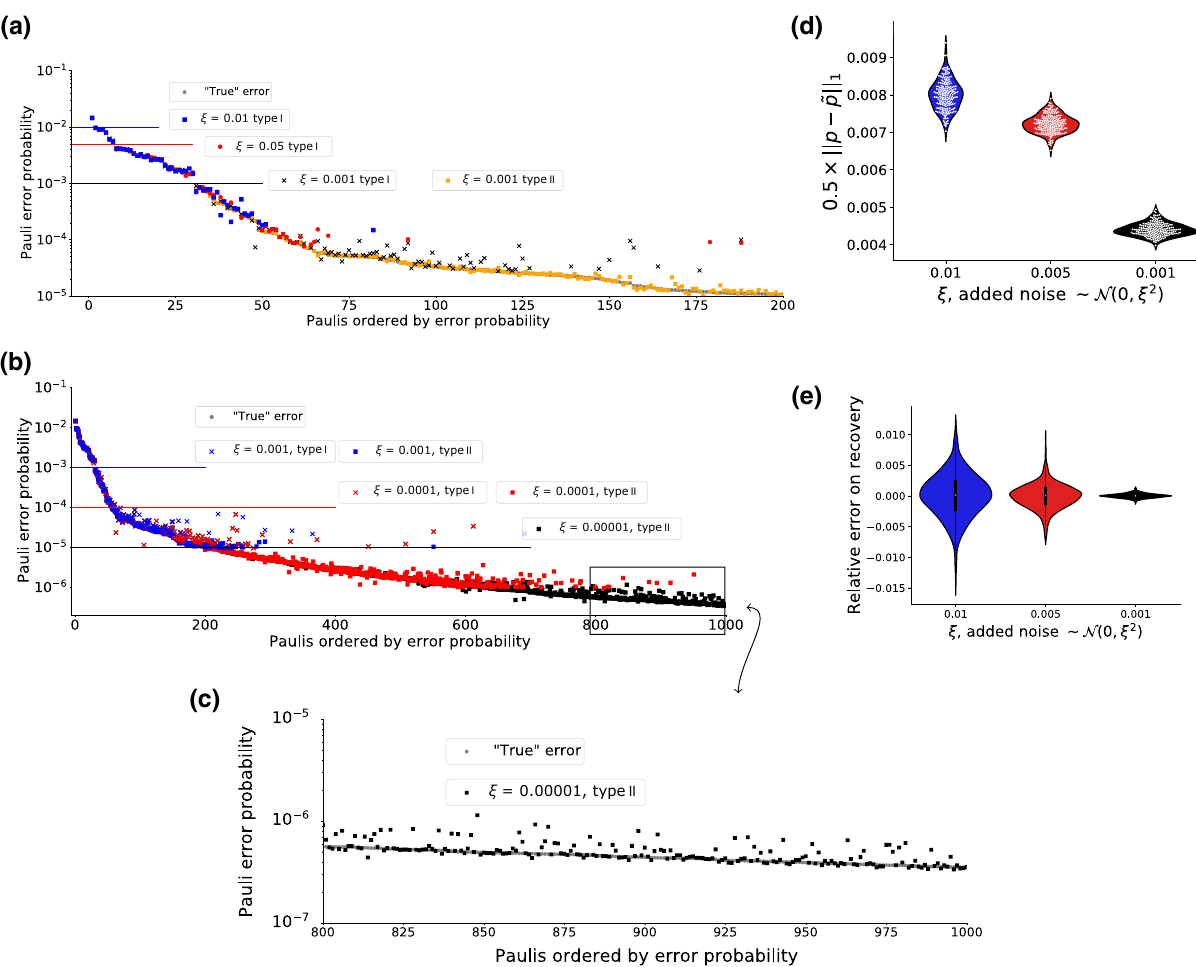
FIG. 1. (a) This figure shows the ability of the reconstruction algorithms to recover sparse Pauli error rates from experimental data. The “actual” error rates (barely visible beneath the data points representing the estimated error rates) are constructed using data from a 14-qubit experiment [38], as described in the main text (Sec. V). Dots indicate recovered Pauli error rates using our algorithm with artificially added zero mean normally distributed noise (variance ξ 2 ) on top of the true error rates to simulate finite sampling and other noise sources. The reconstruction used two experimental designs using a number of randomized benchmarking style experiments: type I (see Sec. V) used 58 and type II (see Sec. V A) used 365 such experiments, each with the same number of samples per experiment. The type-II experimental design runs more experiments and therefore takes more data overall, but allows recovery of an increasing number of Paulis while keeping constant the number of measurements per experiment. (b) The recovery of 1000 different error rates as low as 10 − 7 with high relative precision, when the experimental noise varies between ξ = 10 − 3 –10 − 5 . Notably, the error rates are recovered with a precision almost 2 orders of magnitude below the standard deviation ξ of the noise added to the signal. (c) a more detailed look at the recovery in the regime between 10 − 6 and 10 − 7 with noise levels of ξ = 10 − 5 . (d) Violin plot of the total variational (1-norm) distance between the original probability distribution ( p ) and the reconstructed probability distribution ( ˜ p ), being (cid:6) p − ˜ p (cid:6) 1 1 . The charts show the spread of recovery error over 200 different randomly generated samples of noise. As can be seen, the 2 entire probability distributions are consistently recovered to high precision. (e) A separate experiment where four distinct uniformly random many-body Paulis are added to the oracle with error rates chosen randomly from a normal distribution N ( 0.005, 0.001 ) . The algorithm is run with this additional signal to test if it can recover these Paulis as well. In all cases the planted Paulis are recovered with small relative error, as